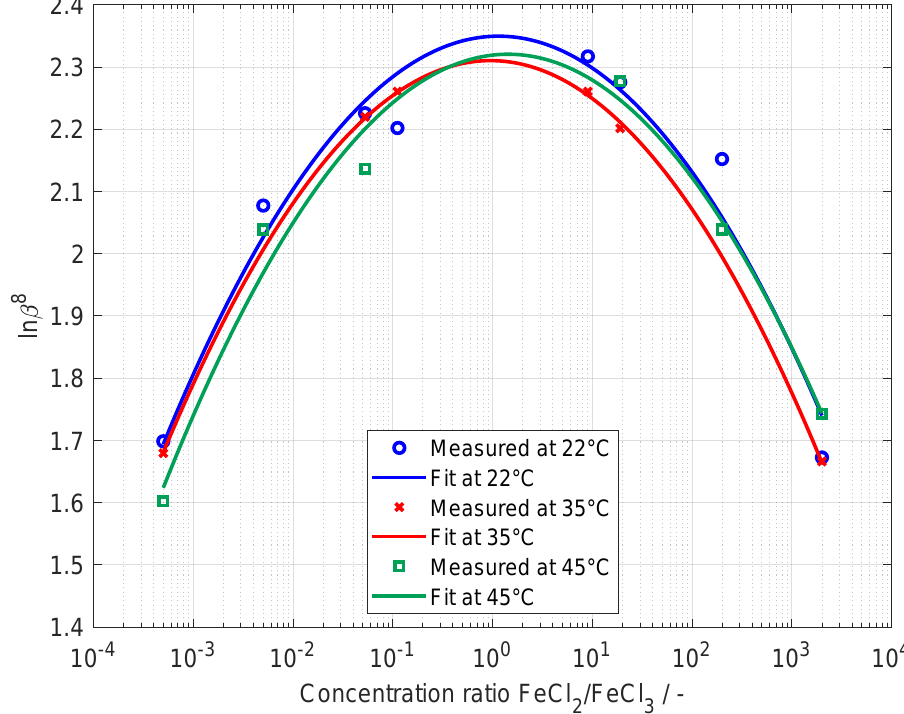
Figure 5. Measured β s at different temperatures and FeCl 2 /FeCl 3 concentration ratios with quadratic